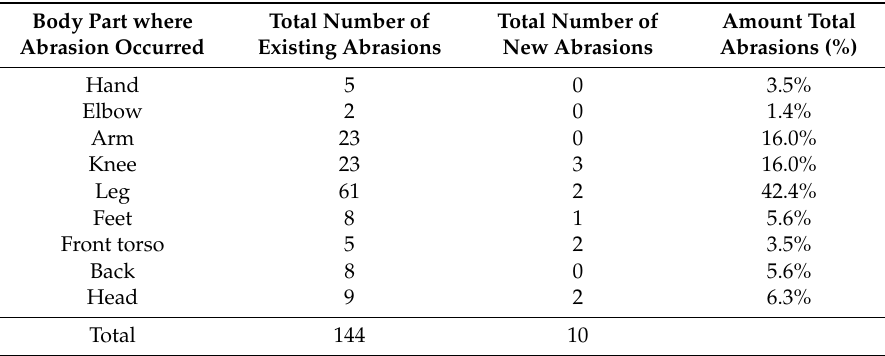
Table 2. Body part most susceptible to abrasions.